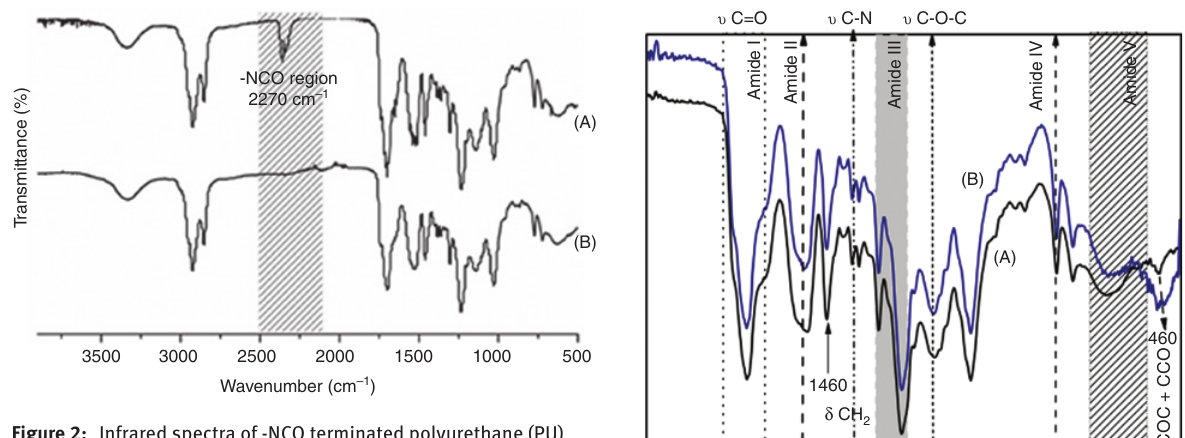
Figure 2: Infrared spectra of -NCO terminated polyurethane (PU) prepolymer (A) during synthesis and (B) after curing synthesized PU-prepolymer in the zone 4000–500 cm − 1 .